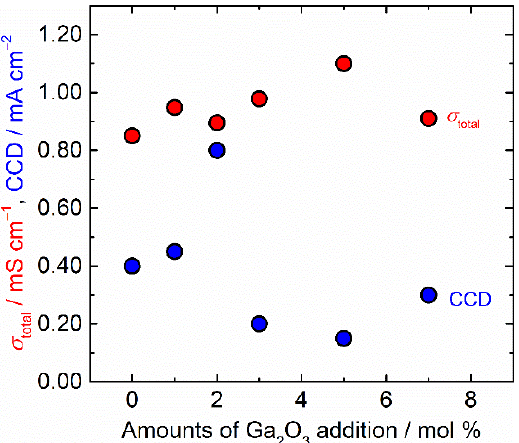
Figure 8. Total ionic conductivity σ total and critical current density (CCD) at room temperature of all sintered samples are plotted against the amounts of Ga 2 O 3 addition.